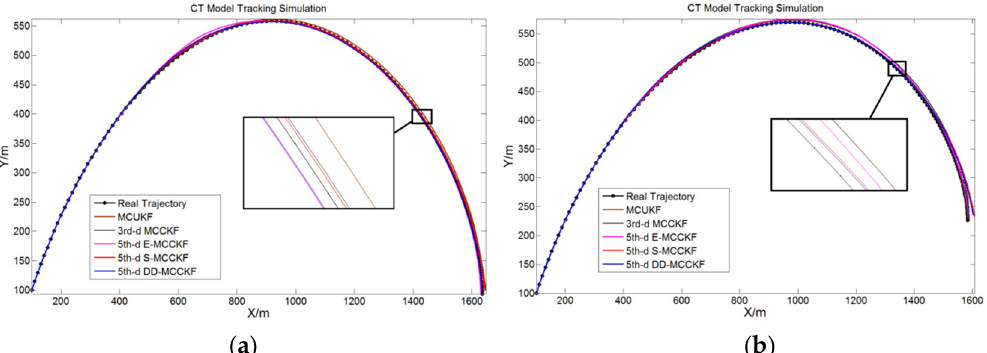
Figure 7. Tracking trajectories of surface target (unmanned surface vessel) under non-Gaussian noise conditions (( a ) is the result under Equation (65) and ( b ) is the result under Equation (66)) .